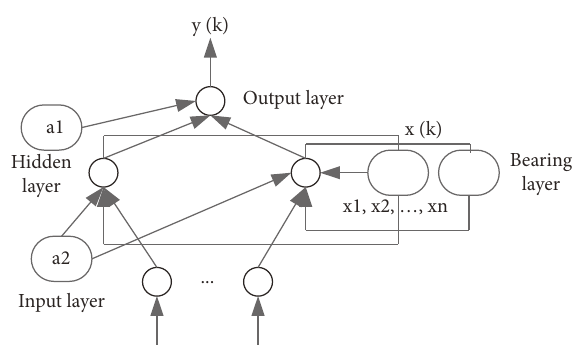
Figure 2: Elman neural network